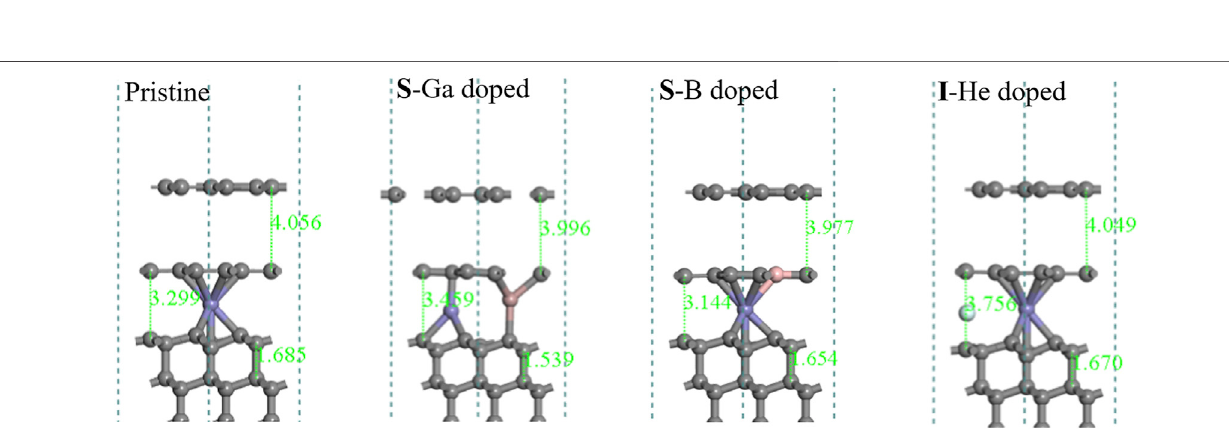
Frontiers in Materials |